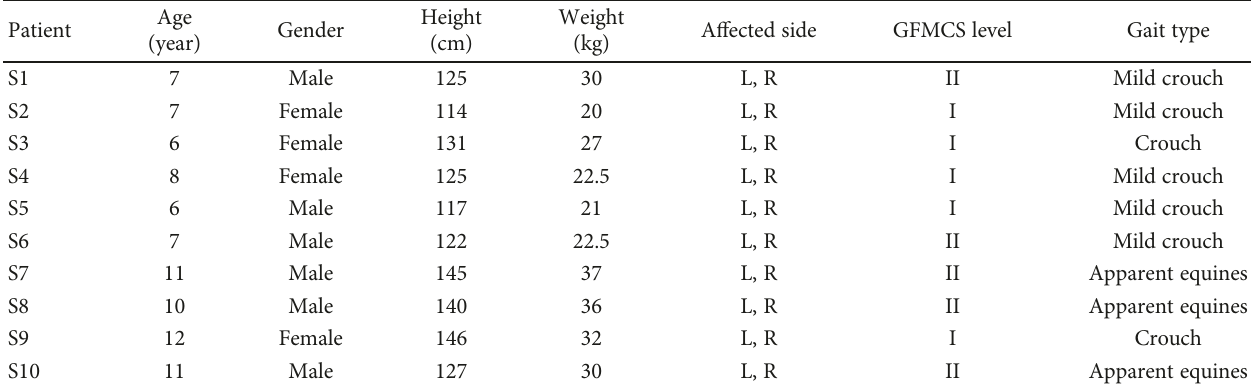
Table 1: Characteristics of